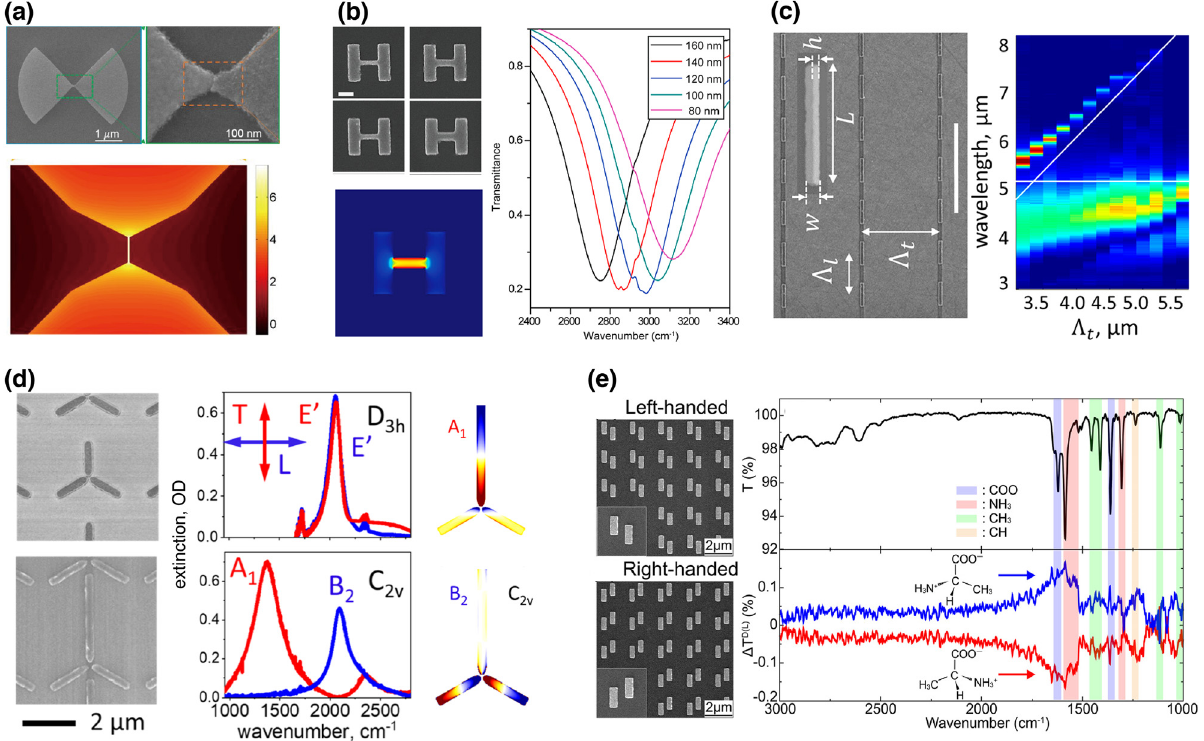
Figure 1: Plasmonic nanoantenna-based SEIRA structures. (a) Bowtie-shapedAuantenna: SEMimages of anantenna witha sub-3nmgap andcalculatedelectric fi eld distributioninthevicinityofgap ata resonant frequency. (b) Charge transfer plasmon (CTP) antenna: SEM images of the gold antennas with various bridge widths and width- dependentSEIRA spectra.(c) Periodicarraysofhalf-wavelength infrared antennas:their SEMimagesandoptical extinctionspectraof thearrays with various transverse periods. (d) Symmetry-broken trimer infrared gold antenna: SEM images and experimental polarization-selective extinction spectra. (e) Chiral gold antenna of staggered nano-rods: SEM images of left- and right-handed antennas and their application to vibrationalcirculardichroismspectroscopy.[(a)Reproducedwithpermissionfromreference[10].Copyright©2017,AmericanChemicalSociety; (b) reproduced with permission from reference [13]. Copyright © 2019, American Chemical Society; reproduced with permission from reference [16].(c)Copyright©2021,AmericanChemicalSociety;(d)reproducedwithpermissionfromreference[19].Copyright©2019,AmericanChemical Society; (e) reproduced with permission from reference [30]. Copyright © 2020, American Institute of